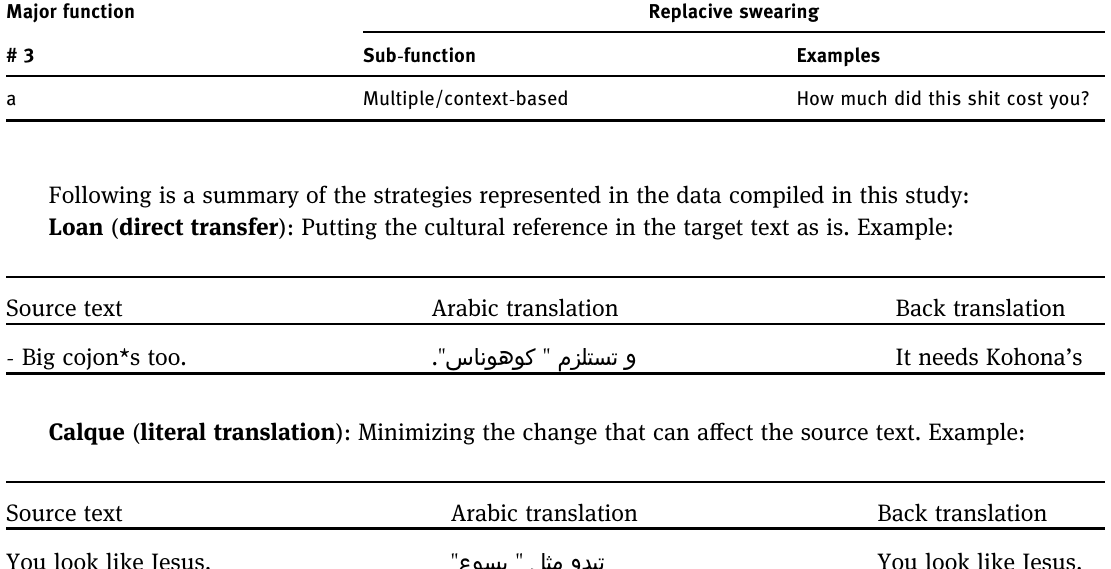
Table 3: Replacive function Major function